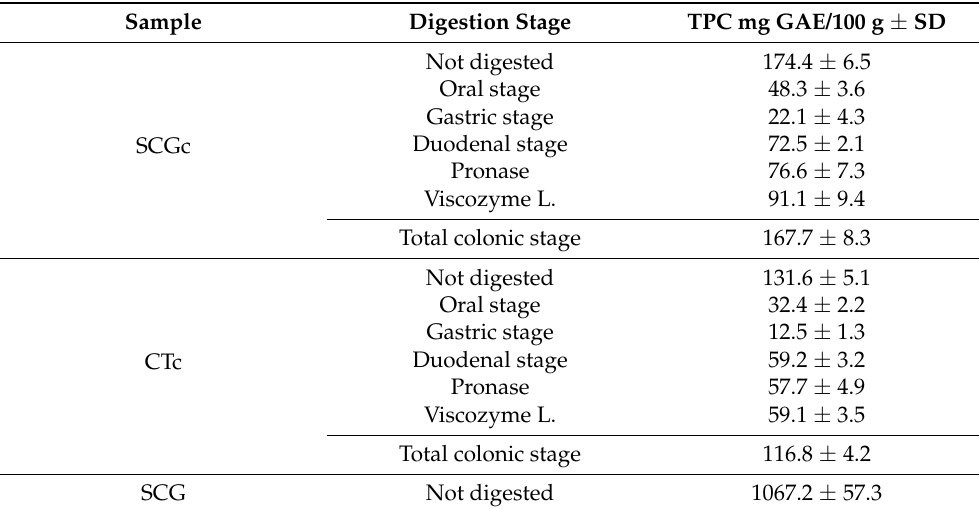
Table 3. Total phenolic content value in not-digested samples and during the simulate gastrointestinal digestion.